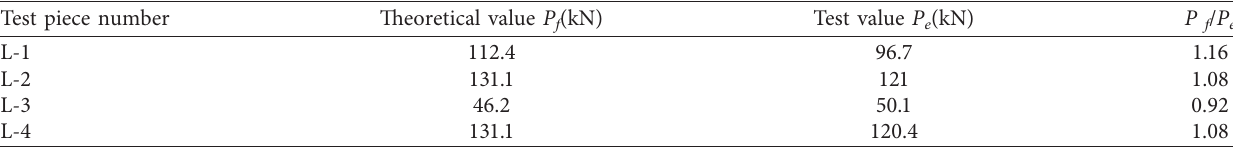
Table 5: Comparison of the theoretical and experimental values of the load corresponding to the normal use limit state. Test piece number